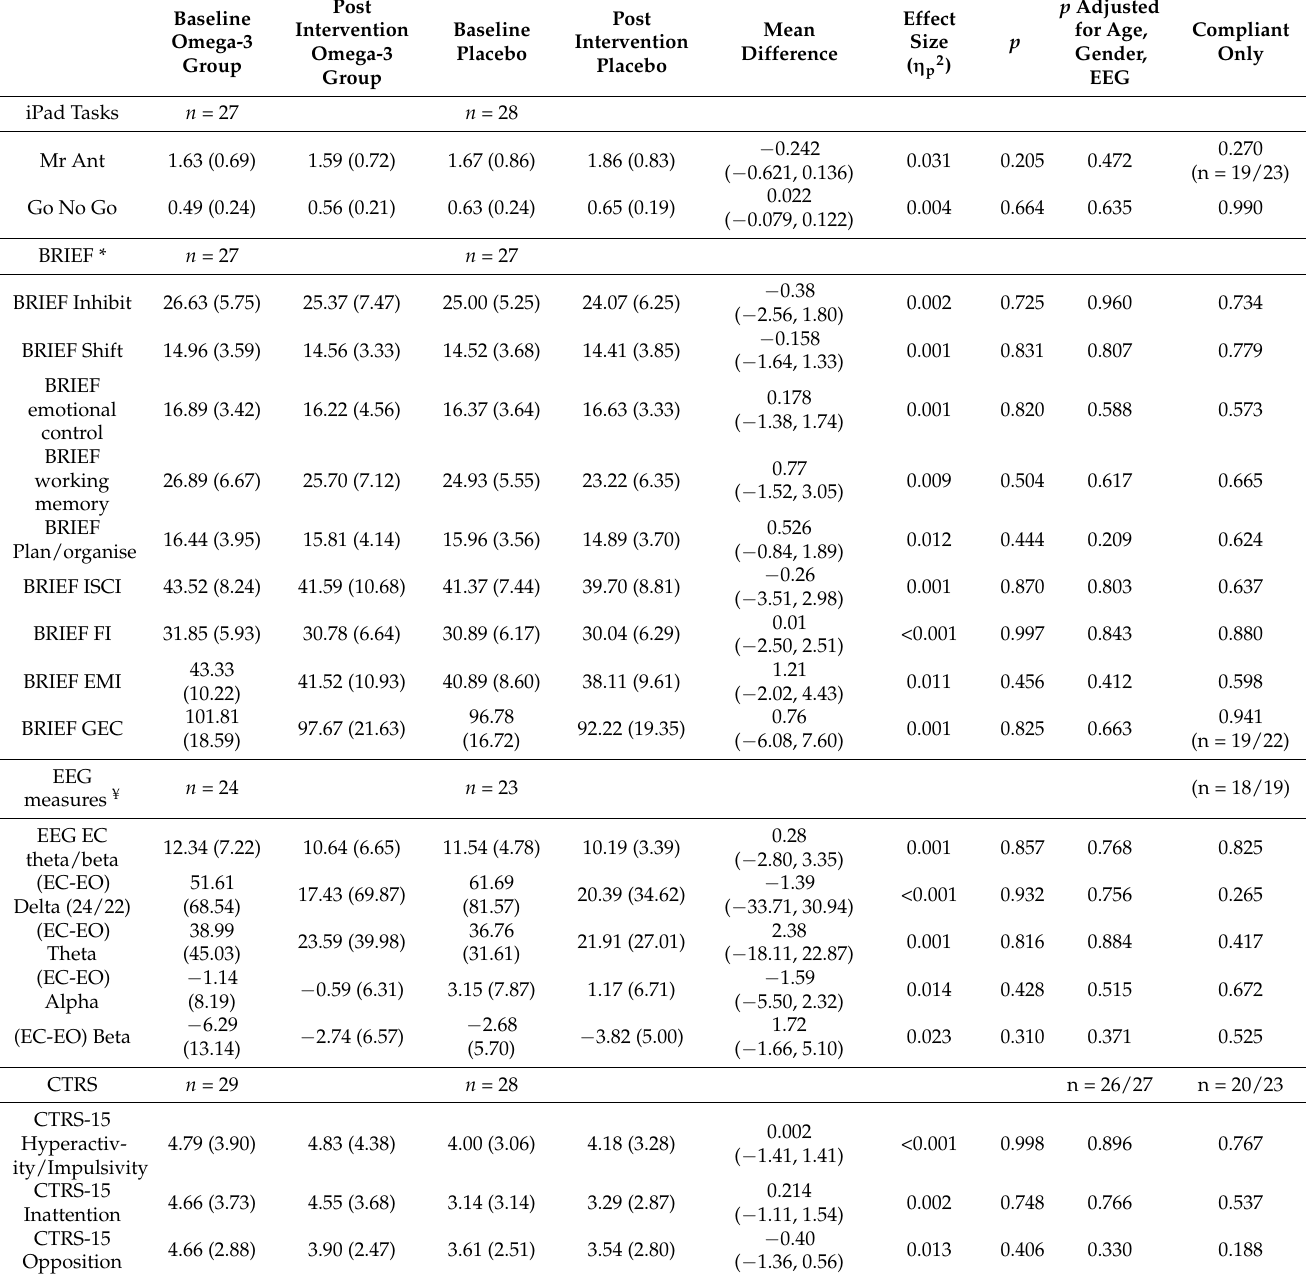
Table 2. Secondary outcome variables at baseline and post-intervention for the Omega-3 and Placebo